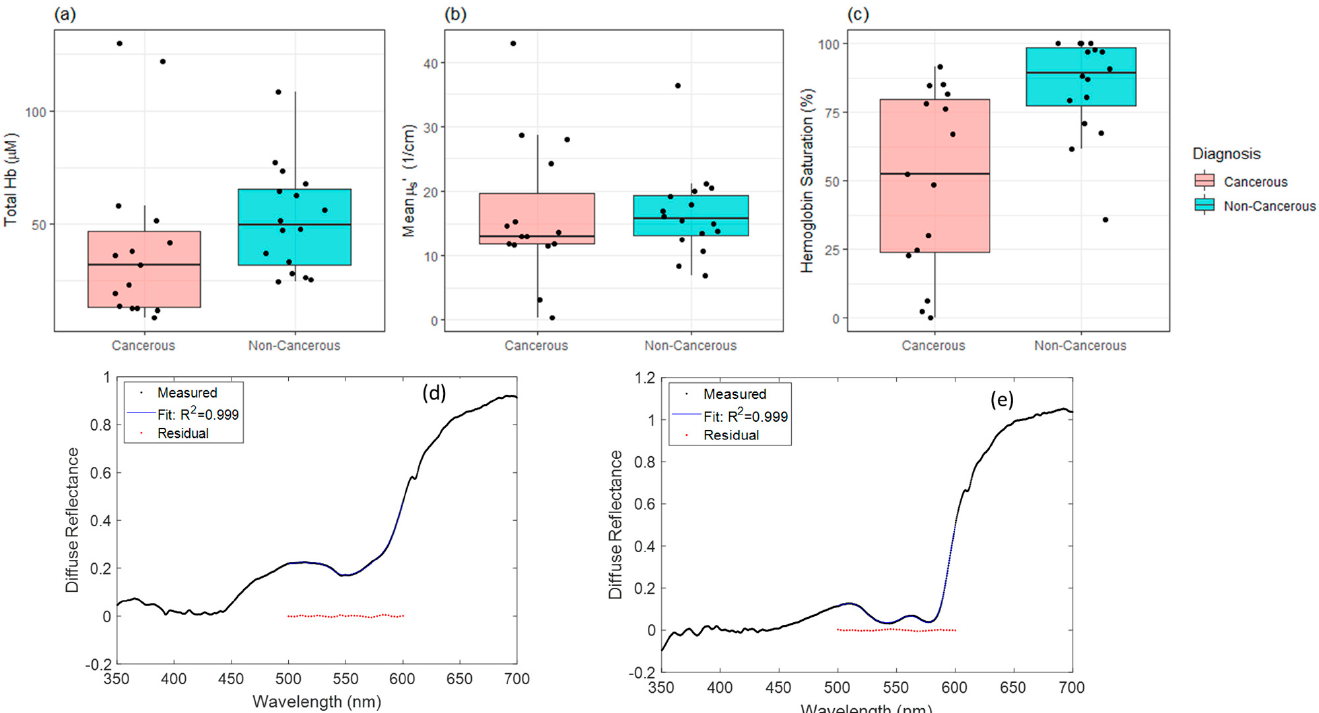
Figure 2. Data summary based on DRS evaluation using pressure-sensing and self-calibrated data. Samples are grouped together and plotted based on measurement sites that are cancerous and non- cancerous. The total hemoglobin ( a ) and mean reduced scattered ( μ s ’ ) ( b ), and the percent hemoglobin saturation ( c ) are shown. Hemoglobin saturation showed a significantly lower value for cancerous as compared to non-cancerous tissue type ( p < 0.001). In addition, sample spectra including one cancerous SCC of the tongue ( d ), and one normal ( e ) tissue site (paired samples from the same patient). Also shown are the fitted spectra and residual plots, with fitting performed over the 500–600 nm wavelength range. In this case, a highly deoxygenated sample is indicated by the presence of only a single absorption band near 550 nm in the tumor sample ( d ), whereas two absorption bands are seen close to 540 and 580 nm in the well oxygenated normal sample ( e ), corresponding to the alpha and beta bands of oxyhemoglobin absorption. The fitted spectra can be difficult to distinguish from the measured spectra, but these largely overlap within the thickness of the plotted